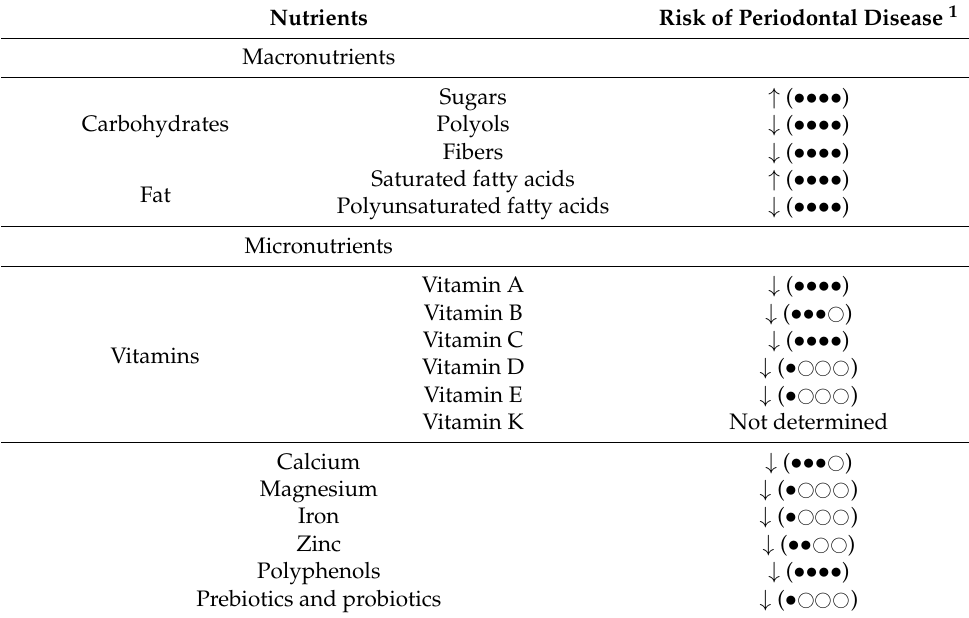
Table 1. Nutrients and their rule in the risk of periodontal